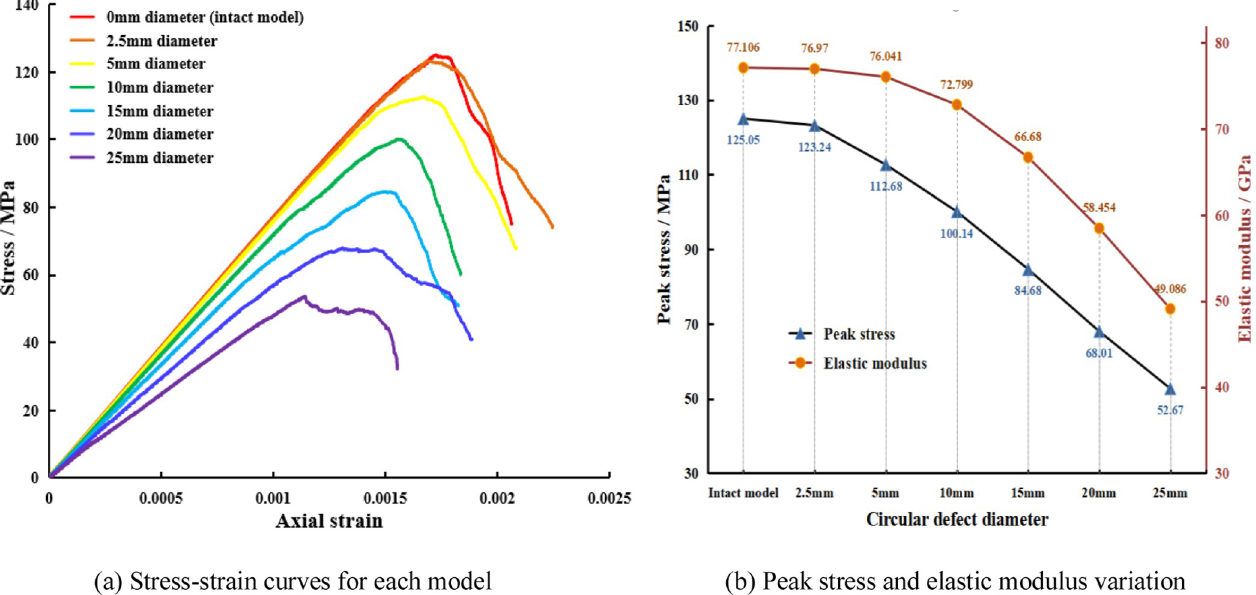
Fig 6. Stress-strain curves, elastic modulus, and peak stress curves of each model. (a) Stress-strain curves for each model, (b) Peak stress and elastic modulus